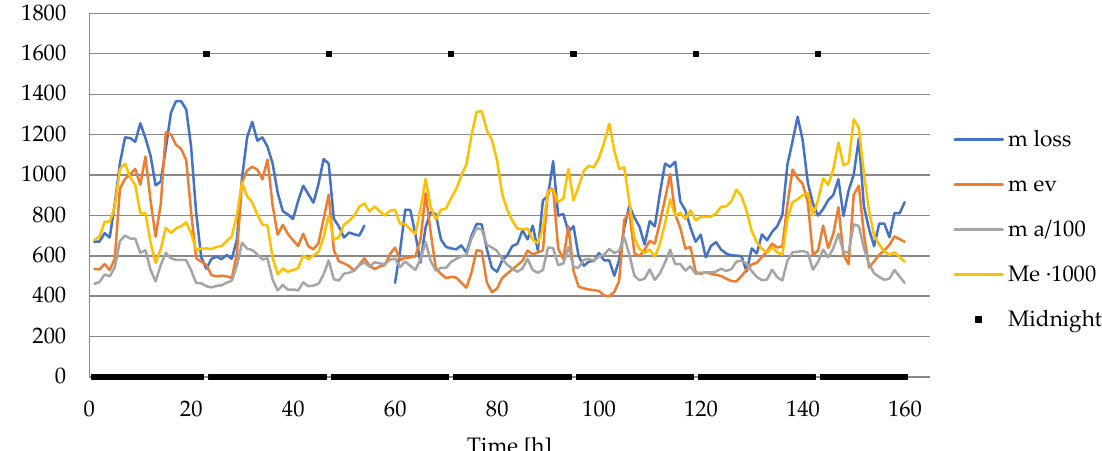
. m ev [tons/h], airflow